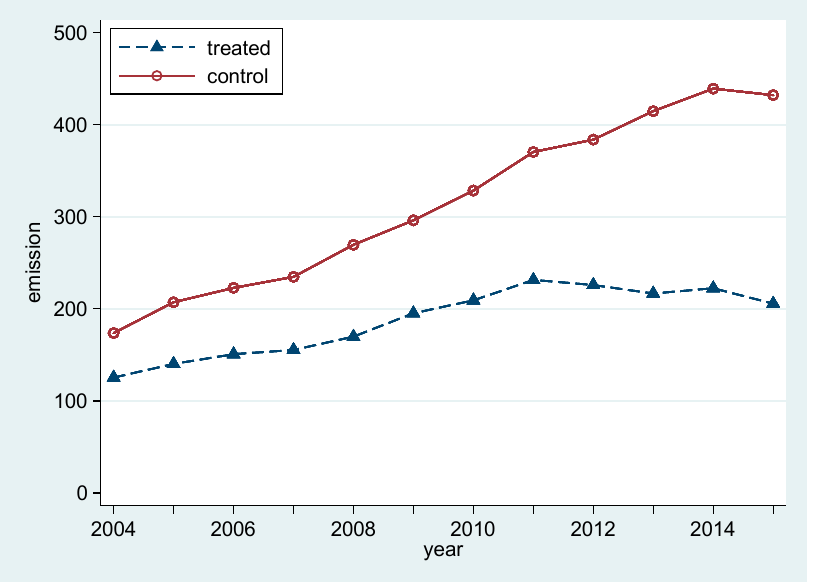
Figure 1. Time trend of carbon emissions in pilot and non-pilot provinces from 2004 to 2015. Table 3. E ff ect test of the carbon trading mechanism pilot.